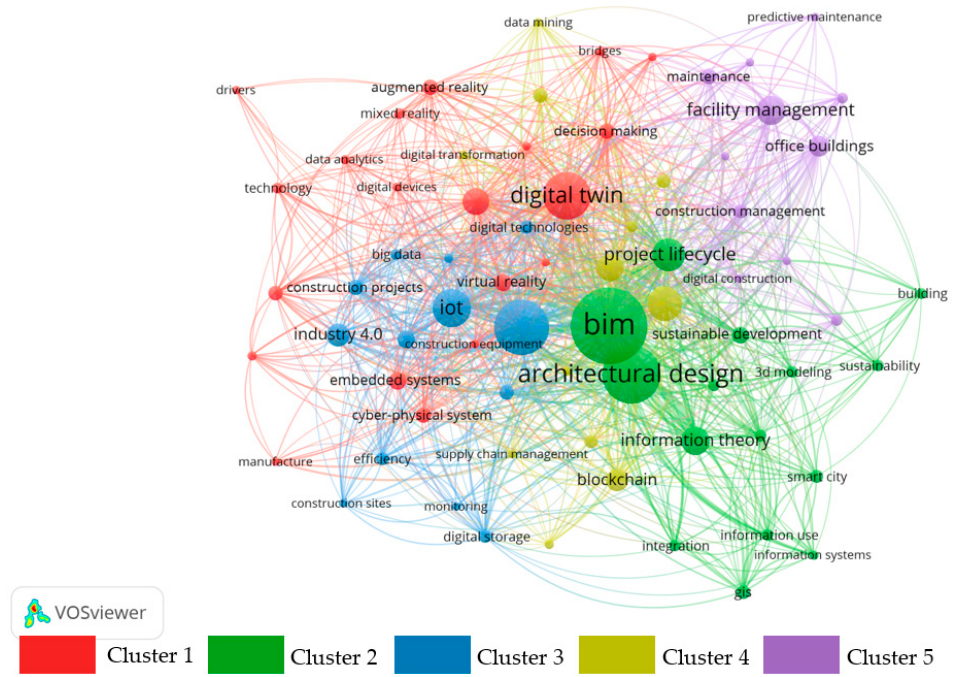
Figure 11. Co-occurrence keywords network map analysis performed with VOSviewer.